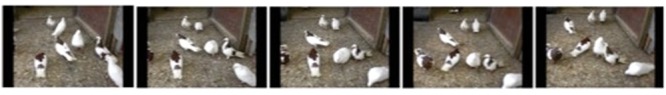
Example of screenshot for the video-clip related to pigeon phobia.